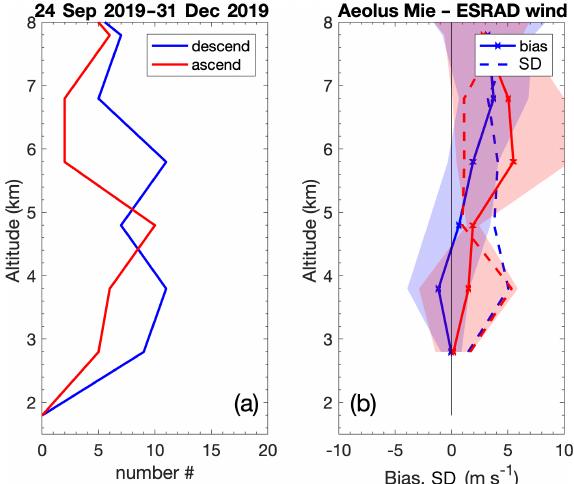
Figure 14. As Fig. 11 but for Aeolus Mie HLOS winds against ES- RAD (summer).